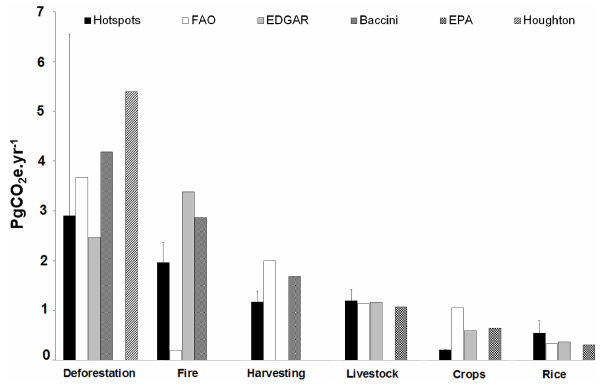
Figure 2. Tropical gross annual emissions (2000–2005) compar- isons for the leading emission sources in the AFOLU sector, for the Hotspots, FAOSTAT, EDGAR, Baccini, EPA, and Houghton datasets. Bars indicate uncertainty estimates (1 σ from mean). No uncertainty estimates are available for the other datasets. Houghton data are net land use emissions (Forestry and Other Land Use) rather than deforestation and are offered for visual comparisons with the Baccini gross deforestation estimate which includes gross defor- estation, fire and wood harvesting. No uncertainty estimates are available for the other datasets. EPA data do not cover forest emis- sions. Forest degradation is the sum of fire and wood-harvesting